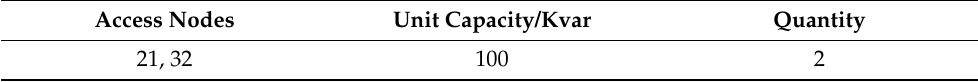
Table 4. SVC Table 4. SVC parameters.